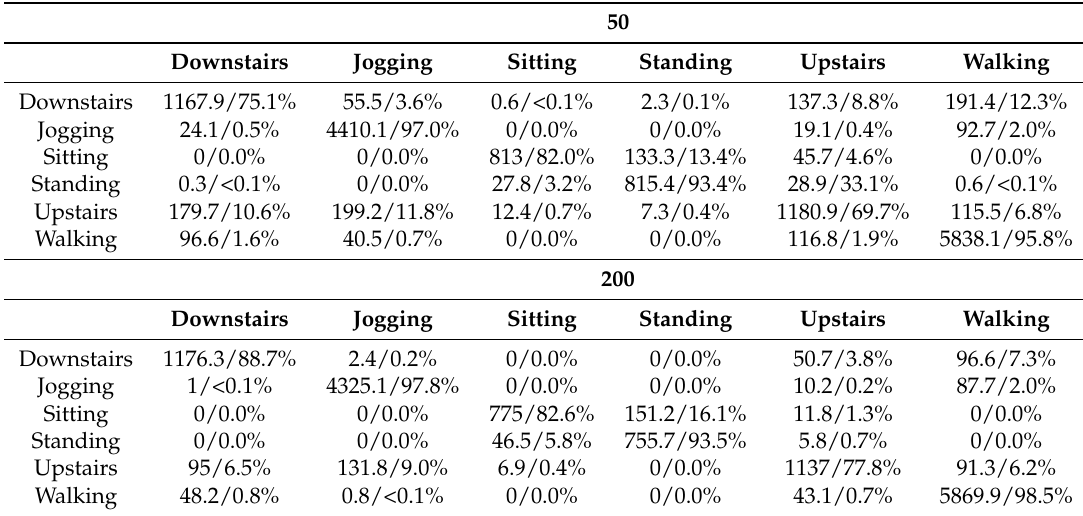
Table 9. Confusion matrix of the original train/test split of the WISDM dataset.